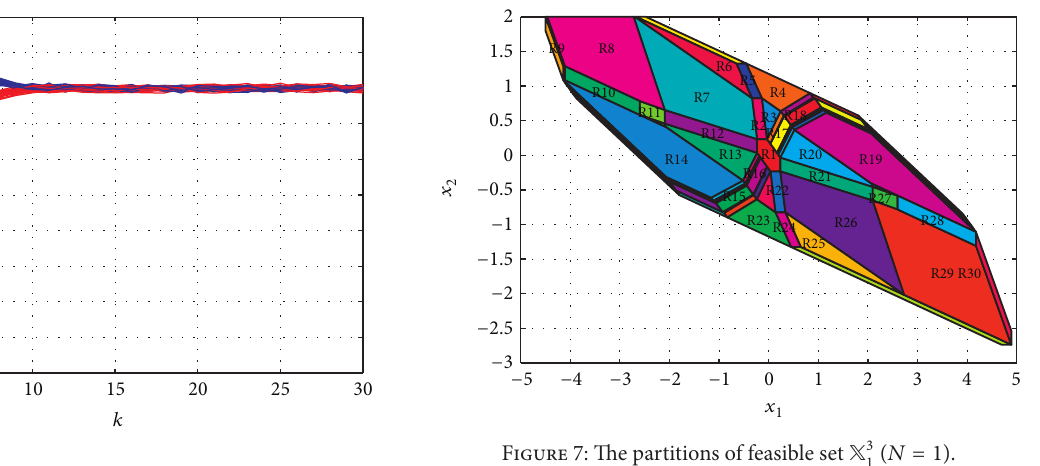
Figure 7: The partitions of feasible set X 3 1 ( 𝑁 = 1 ).